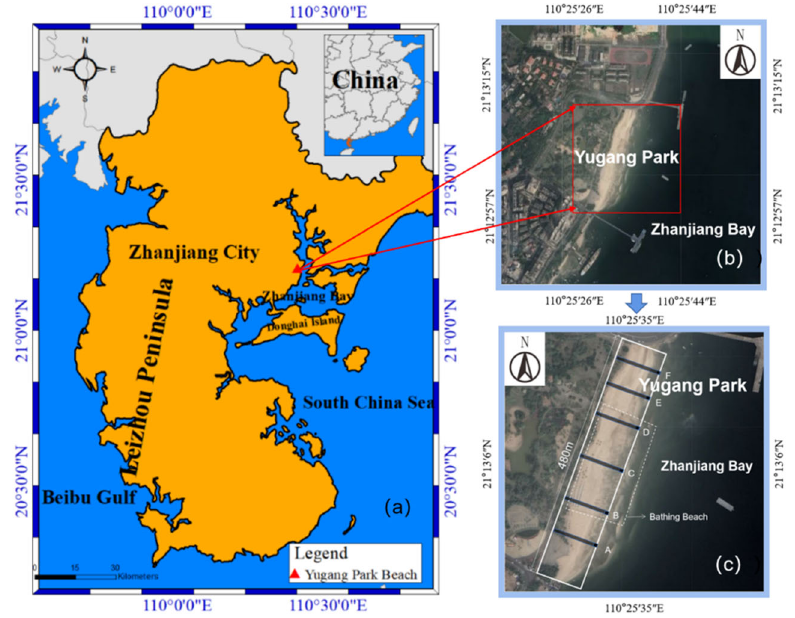
Figure 1. Geographical location of Zhanjiang Bay ( a ), Yugang Park ( b ), and sampling sections ( c ).